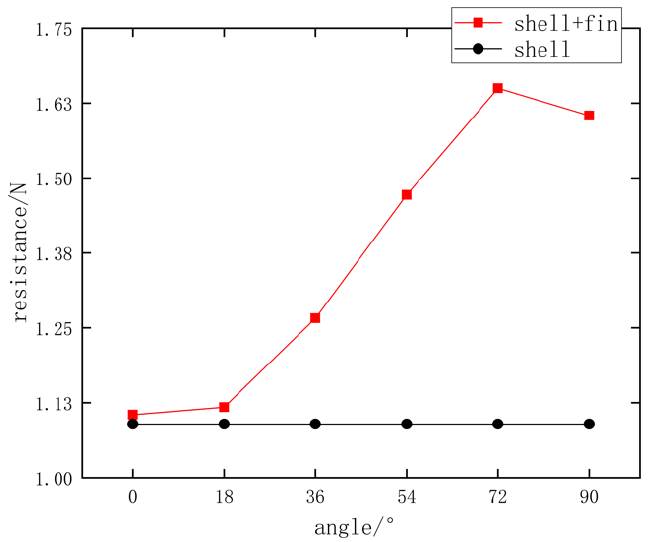
Figure 7. Water resistance of two kinds of shell.